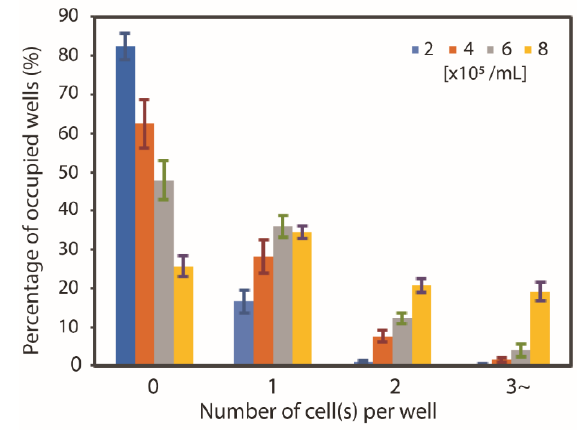
Figure 5. Neutrophils trapping efficiency using 60 µm thick MWA PDMS sheet (n = 3).